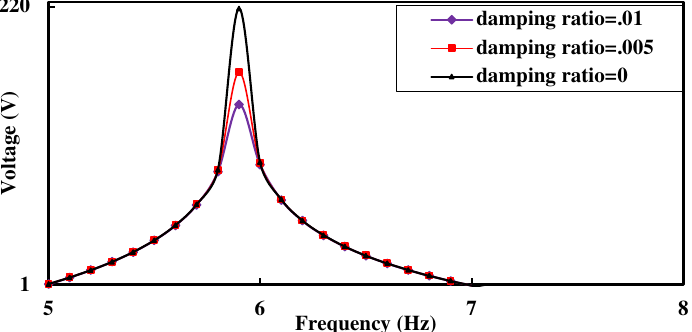
Figure 9. The effect of the damping ratio on the output voltage.